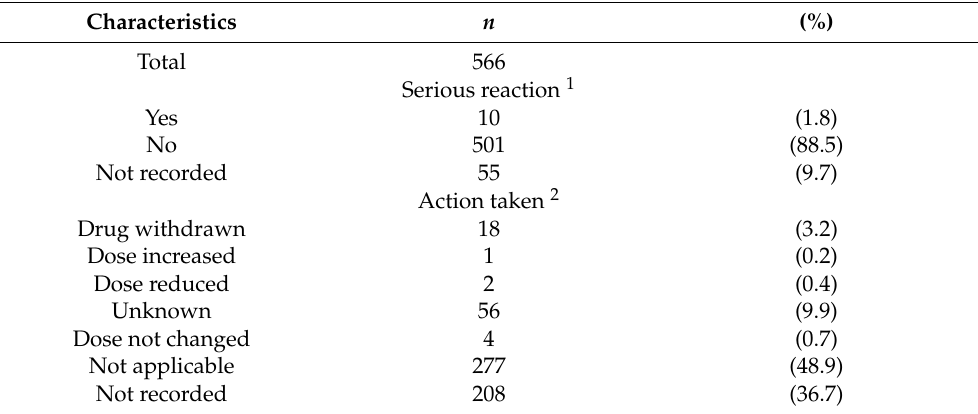
Table 2. Seriousness and actions taken for antimicrobial-related ADRs in ICSRs ( n = 566) reported to the VigiFlow between 2017 and 2021 Sierra